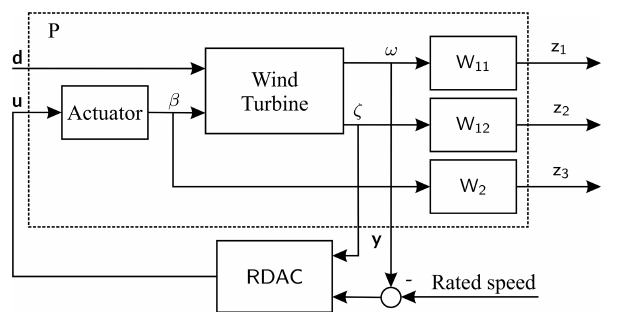
Figure 2. RDAC for wind